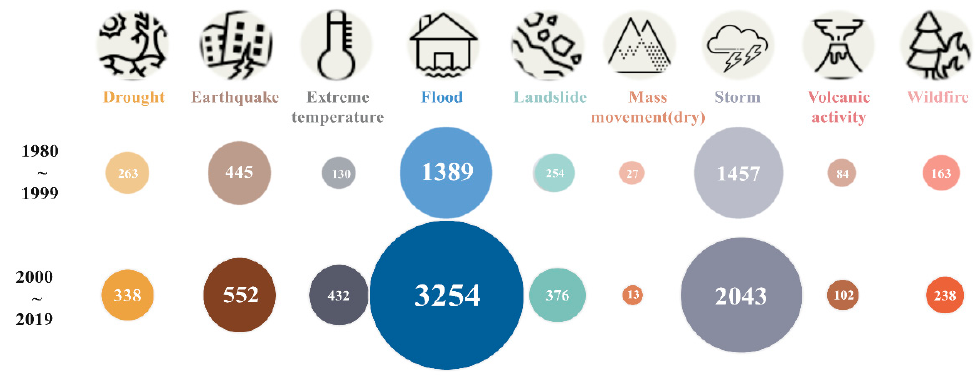
Figure 1. Total disaster events by type: 1980–1999 vs. 2000–2019 from Ref. [3]. 2020, Centre for Re- search on the Epidemiology of Disasters (CRED) & UN Office for Disaster Risk Reduction (UNDRR).